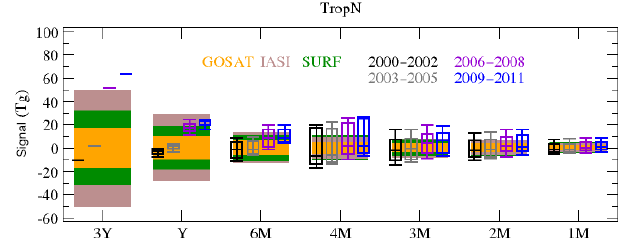
Figure 6. Impact of temporal aggregation on noise (bars) and sig- nal (box plots with median, 25 and 75%) over 3-year time windows. Detection is achieved when the signal is larger than the noise, i.e., for all the occurrences in each box plot which lay outside the match- ing colored bar. Link to Table 3: the TropN lines of the table corre- sponds to the 3Y bars here.